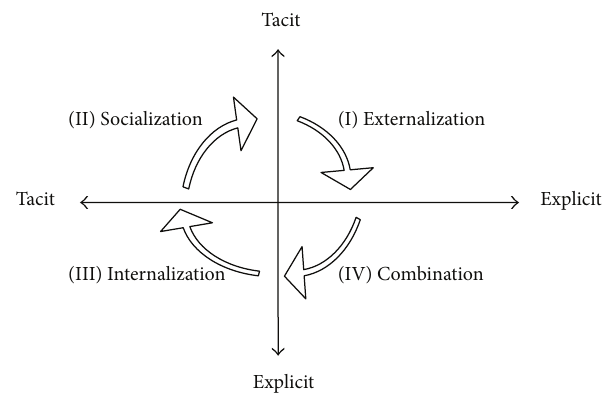
Figure 1: Knowledge conversion modes